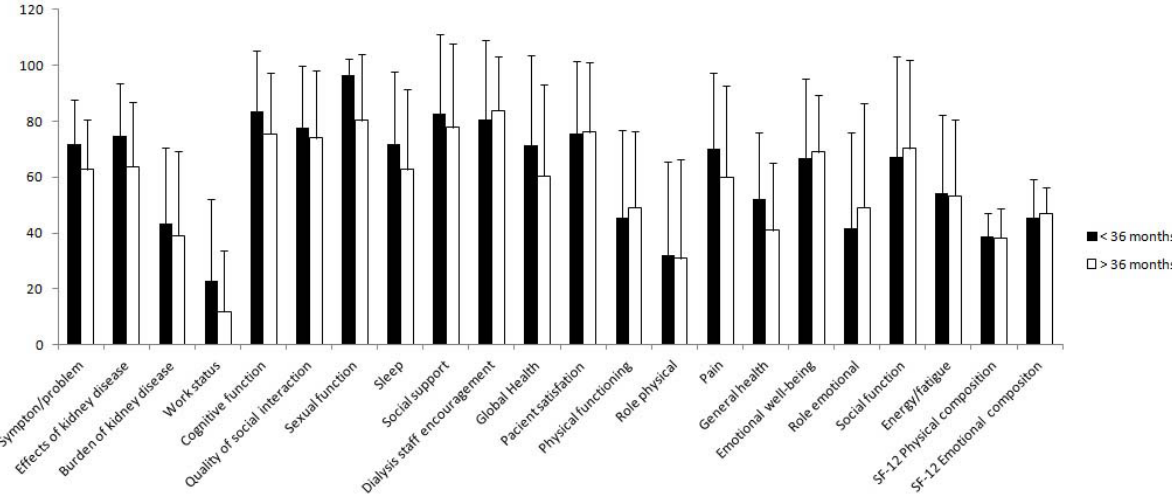
Figure 1 - Comparison of the median time with the dimensions of the KDQOL